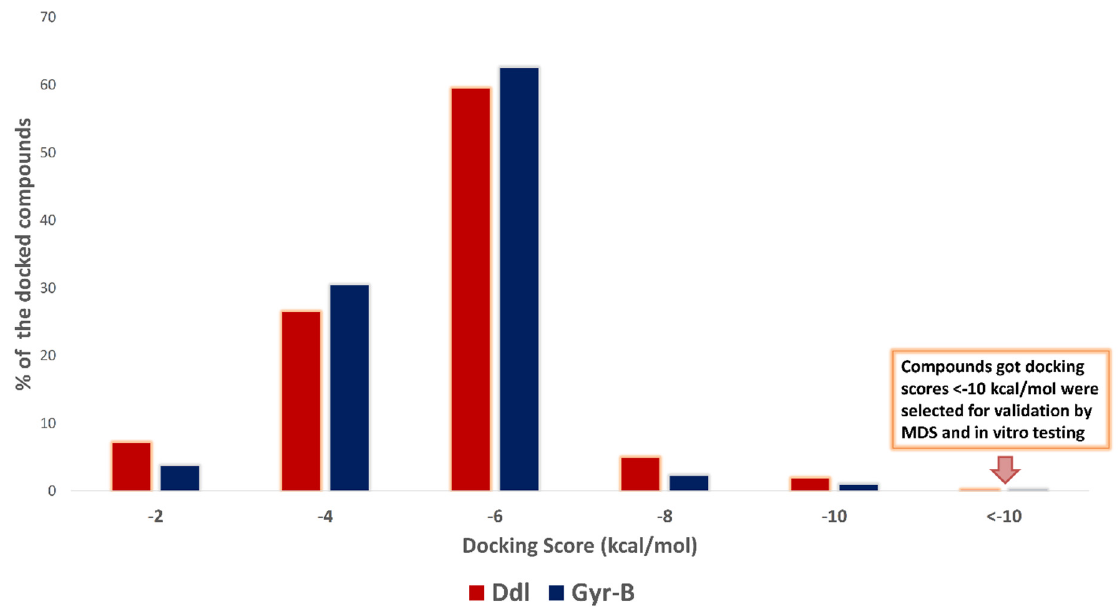
Figure 2. Score distribution of the docked compounds in AfroDb against Ddl-B and Gyr-B.